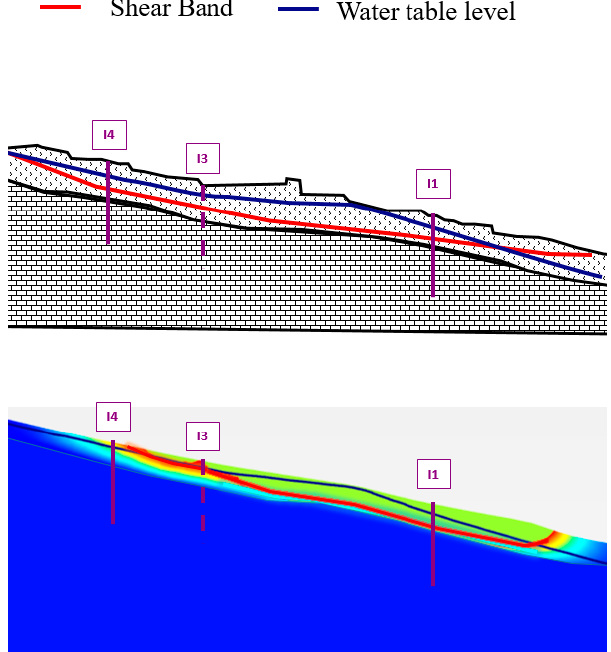
Figure 14. Comparison between the provided shear band evaluated on the basis of the geotechnical tests (image above) and the results of the numerical analysis obtained by PLAXIS (image below).